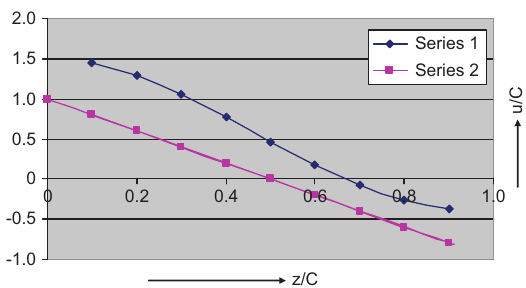
Figure 4 Displacement pattern for triangular wave